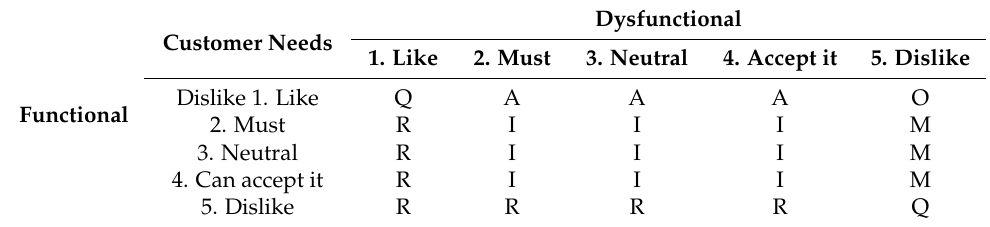
Table 2. Evaluation of traditional Kano.